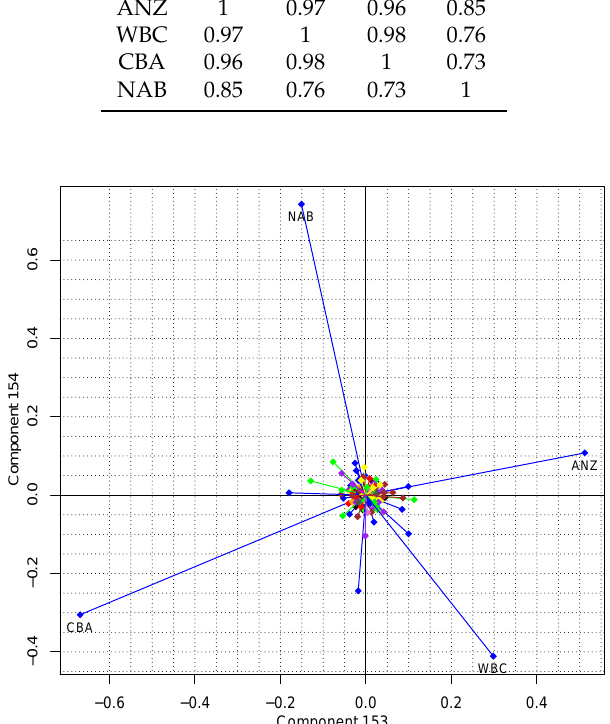
Figure 2. Scatter plots of relative weights of each stock in components 153 and 154 arising from a PCA on a correlation matrix from the whole study period. The lines join the origin to the point representing the coefficient in the 153rd eigenvalue ( x -axis) and 154th eigenvalue ( y -axis). The stocks are colour-coded using the colour scheme described in Figure 1. Stocks with a loading of at least 0.25 in one of the PCs are labelled with their ticker symbol. From this scatterplot, we can conclude that there are four highly correlated stocks structured as two pairs: namely, CBA (Commonwealth Bank of Australia) and ANZ (ANZ), and NAB (National Australia Bank) and WPC